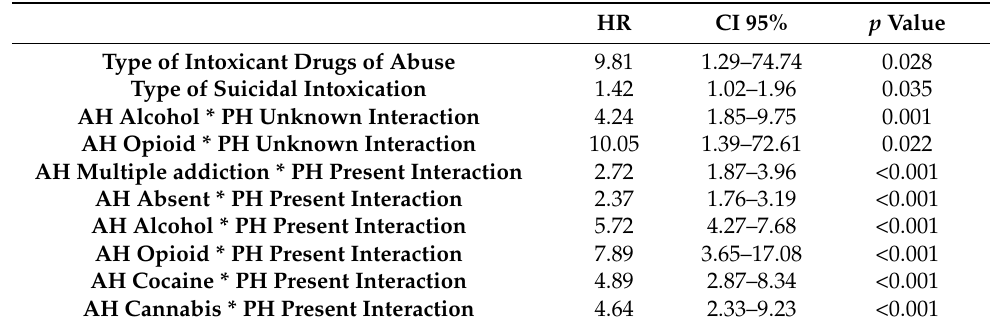
Table 3. Results from the Cox regression analysis of the first readmission within one year after the index episode ( n =